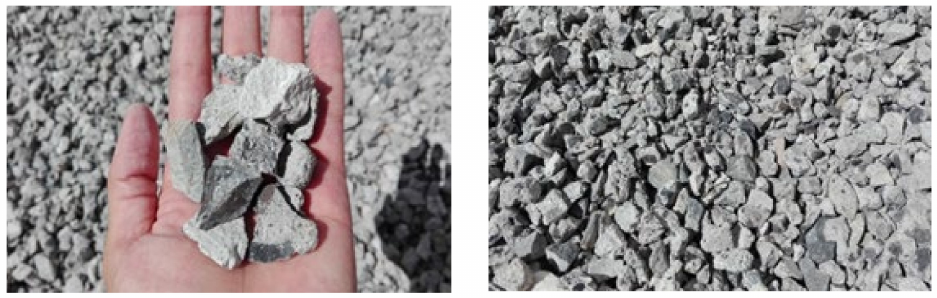
Figure 1. Recycled concrete aggregate